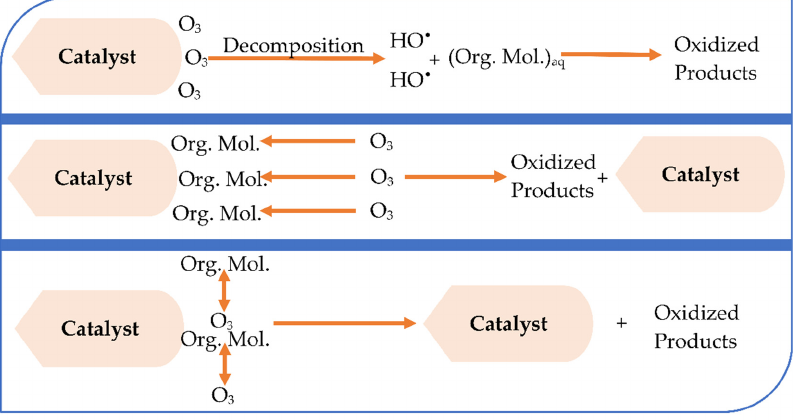
Figure 2. Different mechanisms of heterogeneous catalytic ozonation are based on Nawrocki, 2010 [44].